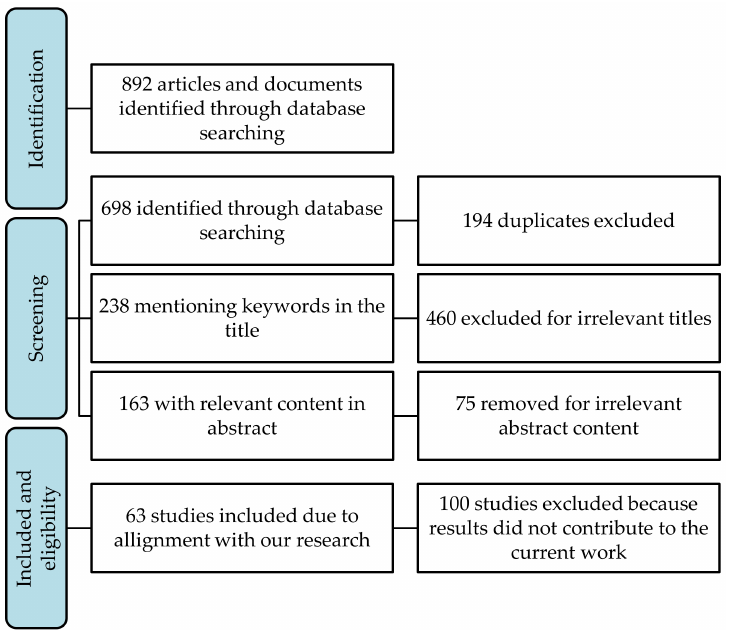
Figure 1. Flowchart identifying steps performed for the literature research using PRISMA